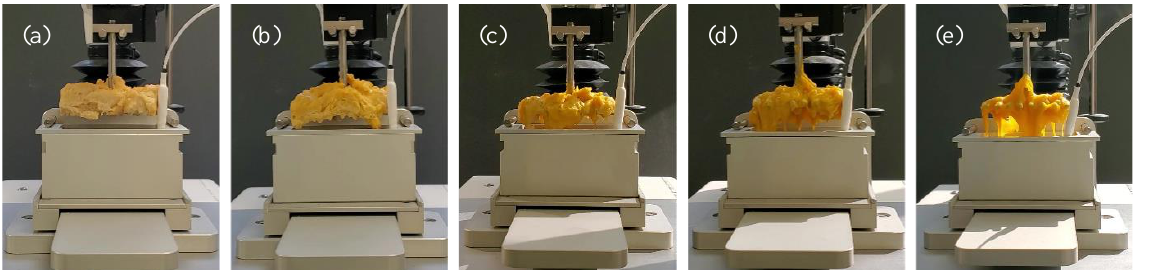
Figure 8. Photographs of melted plant-based cheese alternative samples, 0Z-100C ( a ), 25Z-75C ( b ), 50Z-50C ( c ), 75Z-25C ( d ) and 100Z-0C ( e ) during stretchability test.